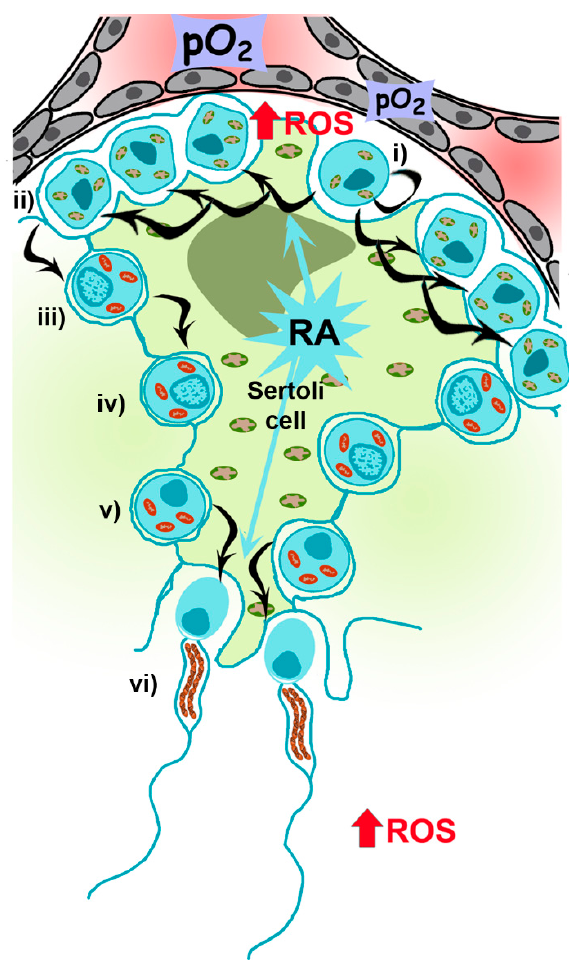
Figure 3. Mitochondrial requirements during spermatogenesis. The spermatogenic process is mainly driven by Sertoli cells (big green cell engulfing the spermatogenic cascade), glycolytic cells carrying orthodox mitochondria, providing and controlling nutritional support to germ cells throughout their development. ( i ) Spermatogonia, proliferating and self-renewing cells, are glycolytic cells presenting orthodox mitochondria and allocated at the basal part of the seminiferous tubule, close to Leydig cells where vascularization is low. Every 60 days, di ff erentiation is engaged by retinoic acid (RA) produced by Sertoli cells, to spermatocyte precursors ( ii ) and up to primary spermatocytes ( iii ), when OXPHOS metabolism becomes the main mechanism to produce ATP (condensed mitochondria, in red). After two meiotic divisions at the spermatocyte stage ( iii,iv ) producing early spermatids ( v ), which need again RA signaling from Sertoli cells to di ff erentiates to spermatozoa ( vi ), with few mitochondria rearranged in the midpiece. Once spermatozoa are produced, they will receive signals from physiological levels of ROS in the epididymis to ensure proper sperm maturation. and in the oviduct to promote hyperactivation and acrosome reaction to allow sperm–oocyte fusion during